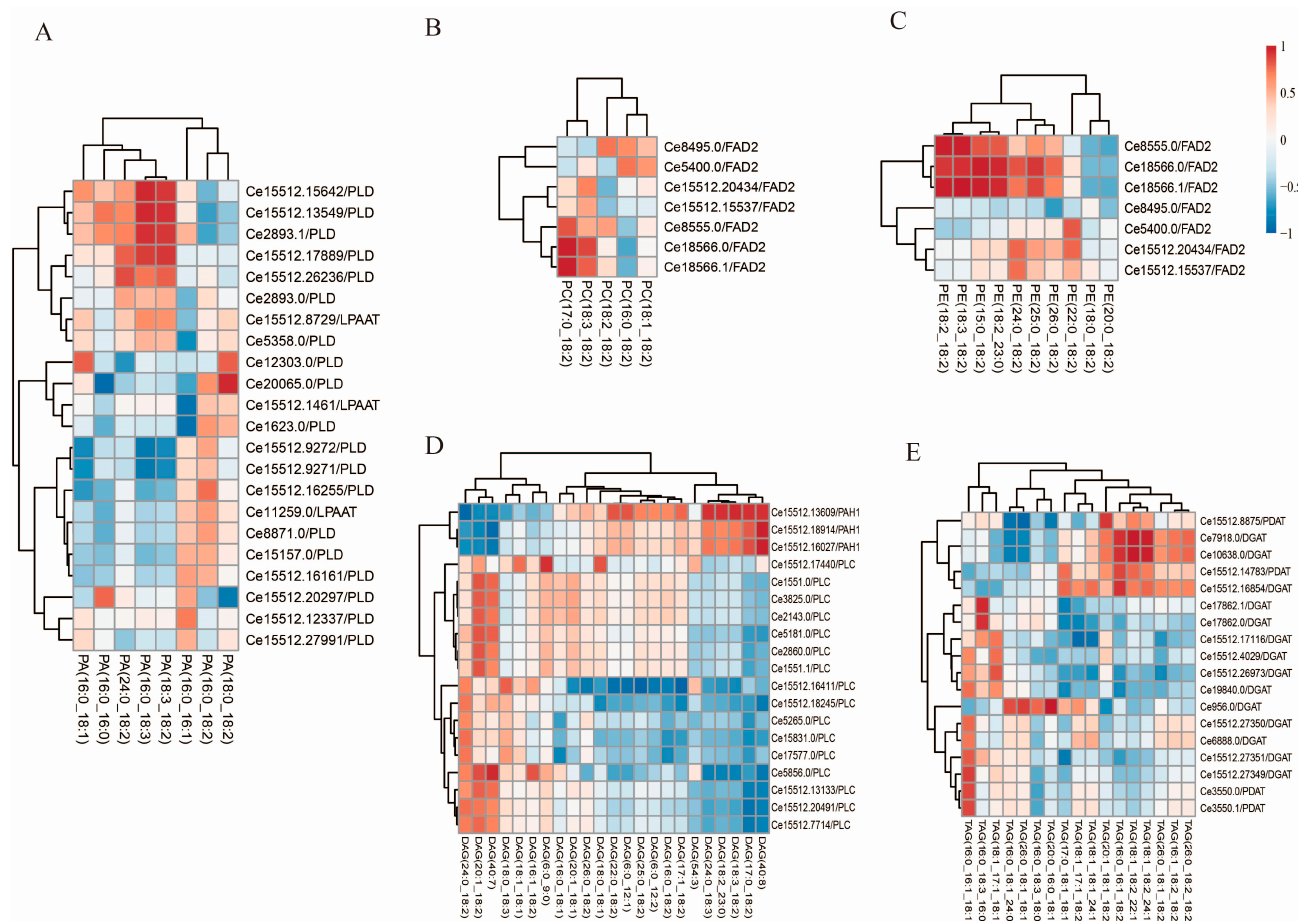
Figure 7. Heat map of the Pearson’s correlation coefficient between gene expression level and intensity of lipid types. The coefficient data is represented by the intensity of the blue or red color as the box at the top right. ( A ) Heat map of the correlation between PA intensity and gene expression levels. ( B ) Heat map of the correlation between PC intensity and gene expression levels. ( C ) Heat map of the correlation between PE intensity and gene expression levels. ( D ) Heat map of the correlation between DAG intensity and gene expression levels. ( E ) Heat map of the correlation between TAG intensity and gene expression levels. Cell colors indicate correlation coefficients from negative (blue) to positive (red).